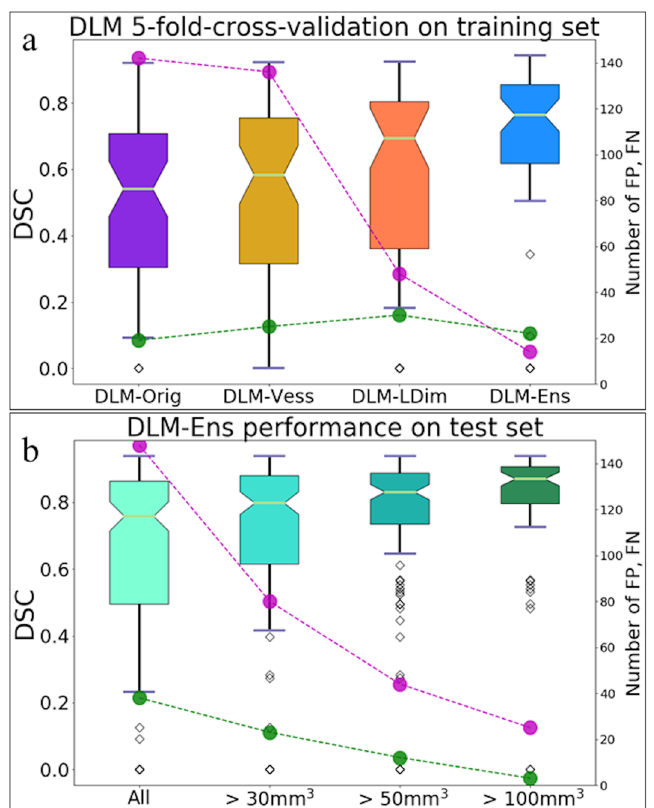
Figure 3. Performance of the different DLMs on the training set using five-fold-cross-validation ( a ). Segmentation performance of the DLM-Ens on the independent test set with respect to aneurysm volumes ( b ). Magenta circles represent the total number of false positives and green circles indicate the total number of false negatives.